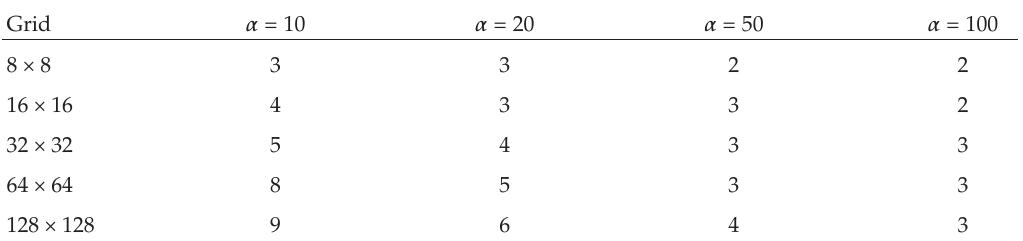
Table 3: Results for 2D unsteady Oseen problem di ff erent values of α (cid:5) exact solves (cid:6) and ν (cid:7) 0 . 01. Grid α (cid:7)